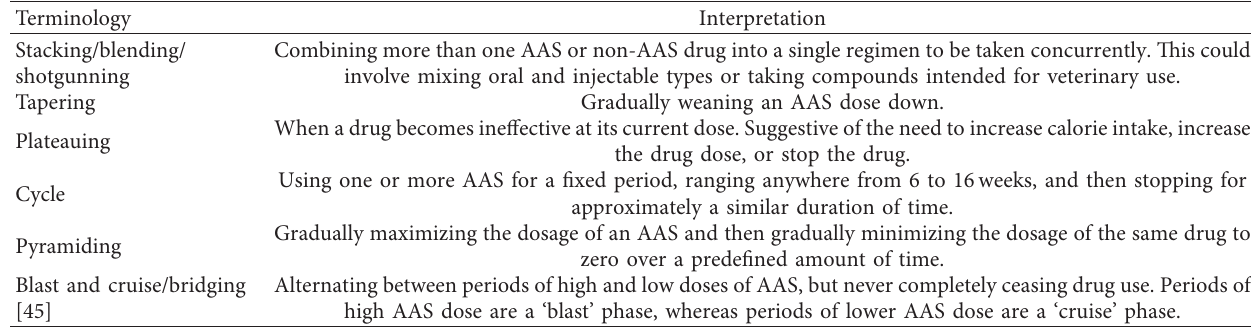
Table 2: Common terminologies used by the AAS user